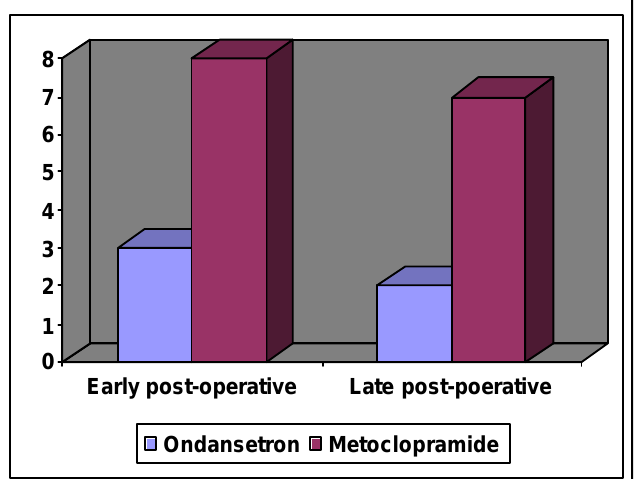
Fig. 1 : Incidence of vomiting in Ondansetron and metoclopramide group in early and late post-operative